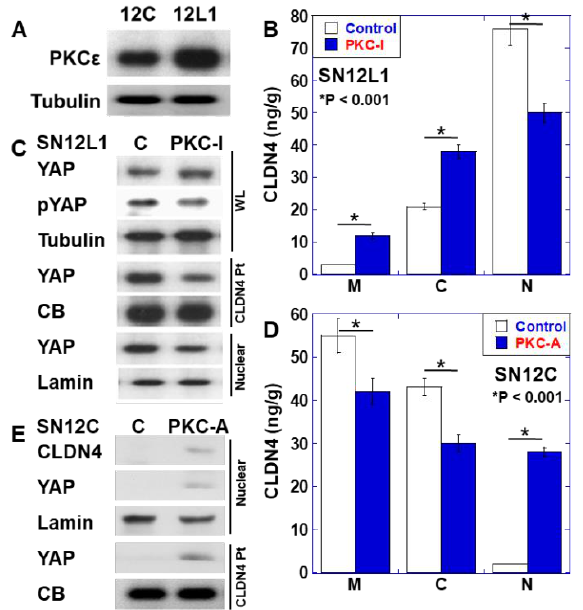
Figure 3. E ff ect of PKC ε on the nuclear localization of CLDN4 and Yes-associated protein (YAP) activation in renal cell carcinoma cell line. ( A ) Expression of PKC ε examined using immunoblotting. ( B ) Alteration of the subcellular localization of CLDN4 by PKC-I (10 µ M for 24 h) in SN12L1 cells. CLDN4 protein level was measured using enzyme-linked immunosorbent assay (ELISA). ( C ) YAP inactivation in SN12L1 cells treated with PKC-I. ( D ) Alteration of the subcellular localization of CLDN4 using PKC-A (5 µ M for 24 h) in SN12C cells. CLDN4 protein level was measured using ELISA. ( E ) YAP activation in SN12C cells treated with PKC-A. Error bar, standard deviations calculated by ordinary analysis of variance from three independent examinations. M, membrane fraction; C, cytosol fraction; N, nuclear fraction; CB, Coomassie blue; Pt, immunoprecipitated; PKC-I, PKC ε inhibitor peptide; PKC-A, PKC ε activator; WL, whole-cell lysate; Nuclear, nuclear fraction; pYAP, phosphorylated